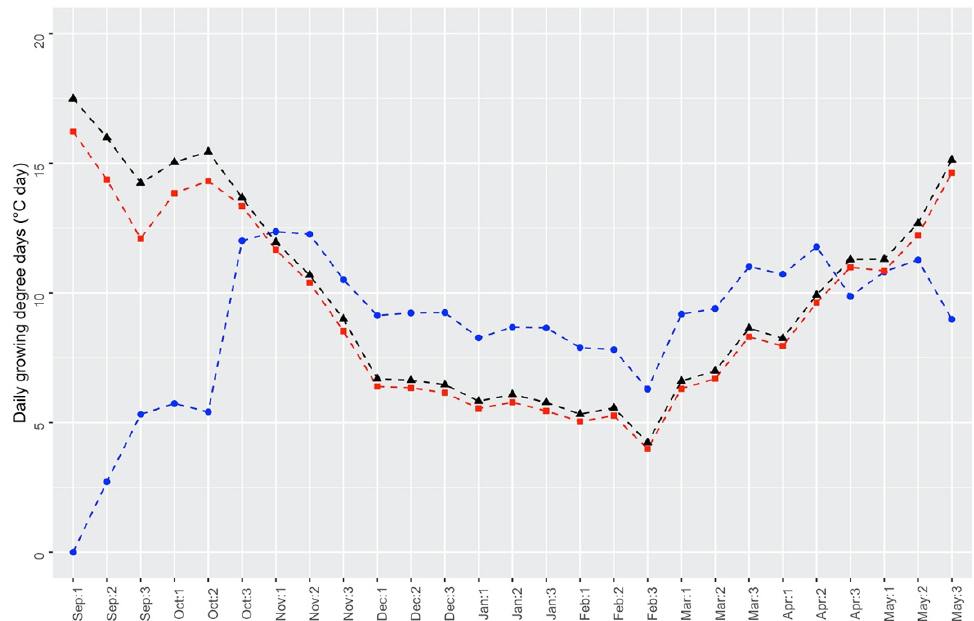
Figure 7. Thermal time accumulated in one day, at the beginning of each decade from September to May. The blue line with circles refers to 9 DAH seeds (DAH = days after harvest), the red line with squares refers to 600 DAH seeds, and the black line with triangles refers to 2080 DAH